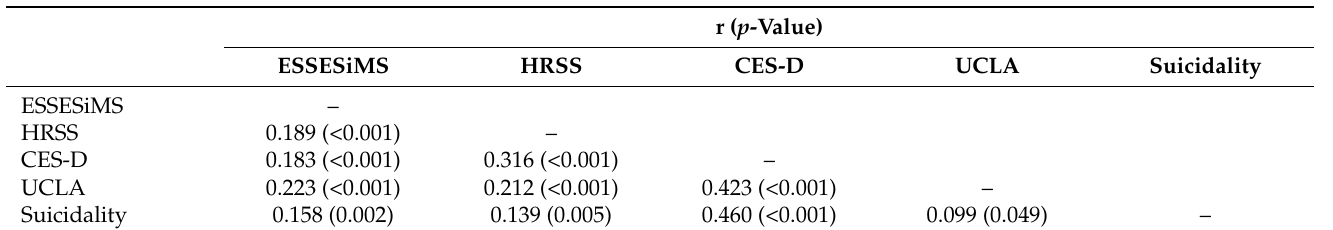
Table A2. Concurrentvalidity ofthe Enacted SexualStigma ExperiencesScale in MilitaryService